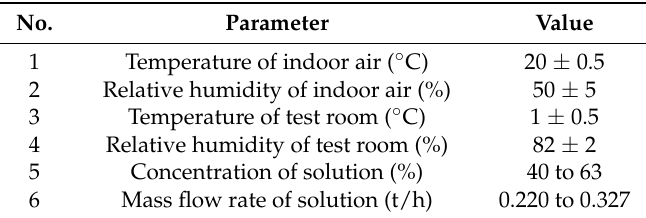
Table 5. Values of experimental parameters [79].